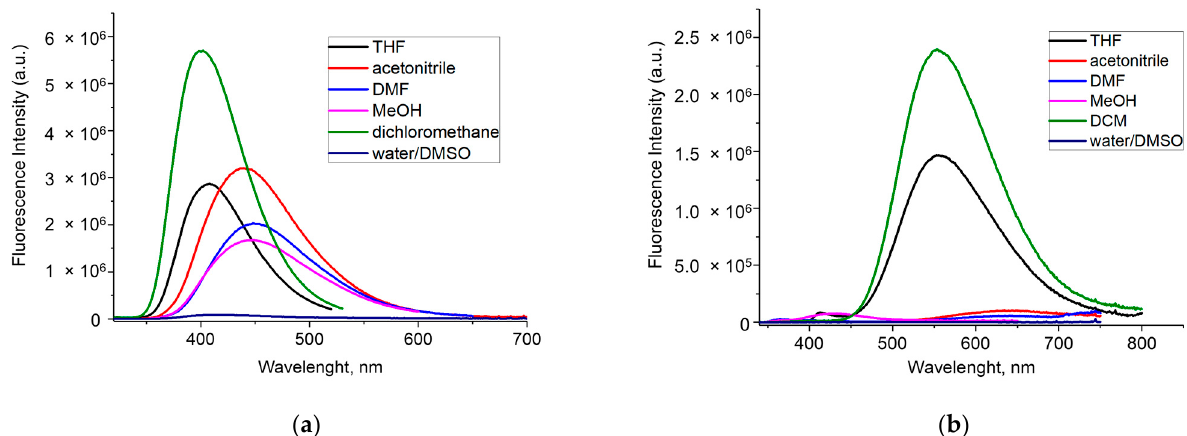
Figure 5. Emission spectra of 10f ( a ) and 10g ( b ) in various solvents, C = 1 × 10 − 6 M. Table 2. Photophysical parameters 10f and 10g in various solvents.